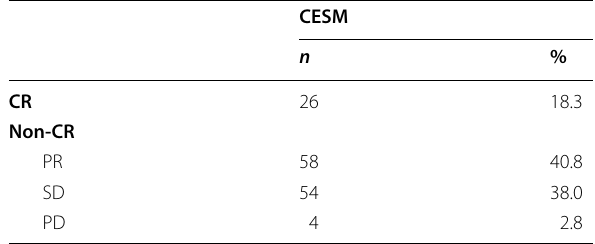
Table 2 Treatment response to NAC by